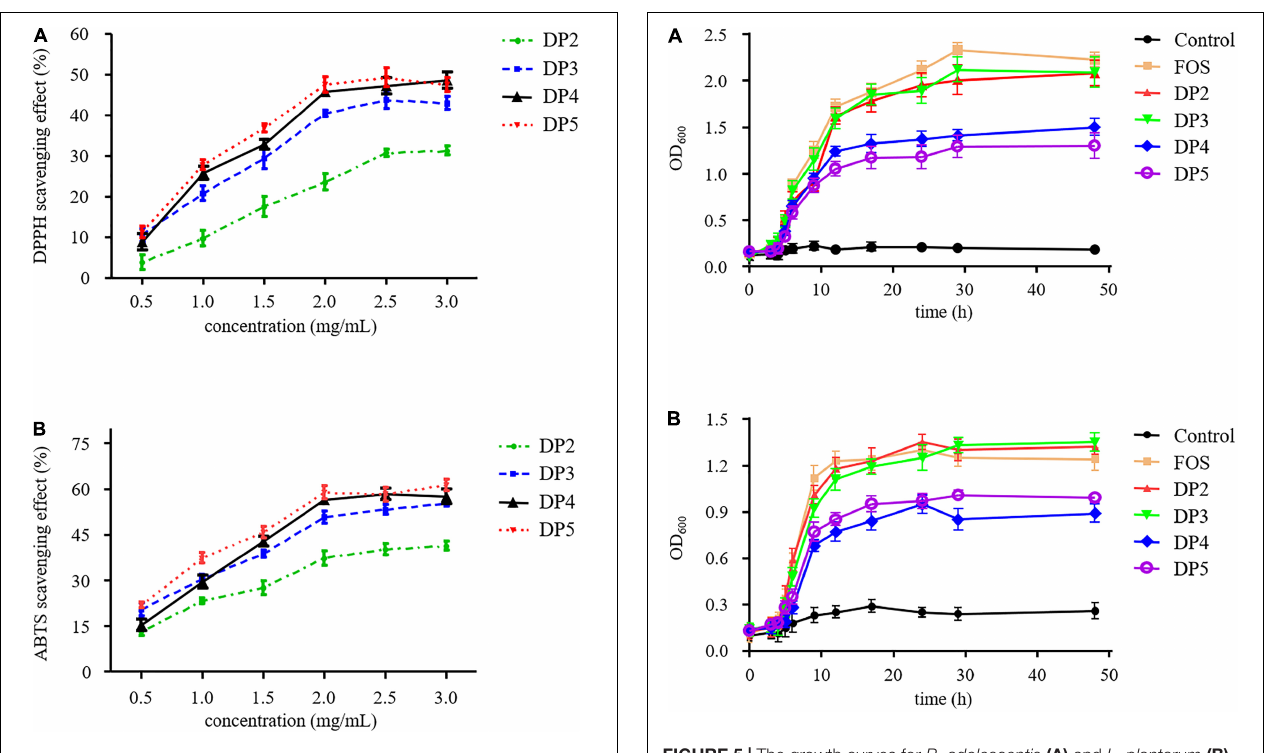
FIGURE 5 | The growth curves for B. adolescentis (A) and L. plantarum (B) grown in basal medium supplemented with purified LOs. The growth curves for each strain with a range of test samples were determined by measuring the OD of the cultures at 600 nm intermittently over a 48 h